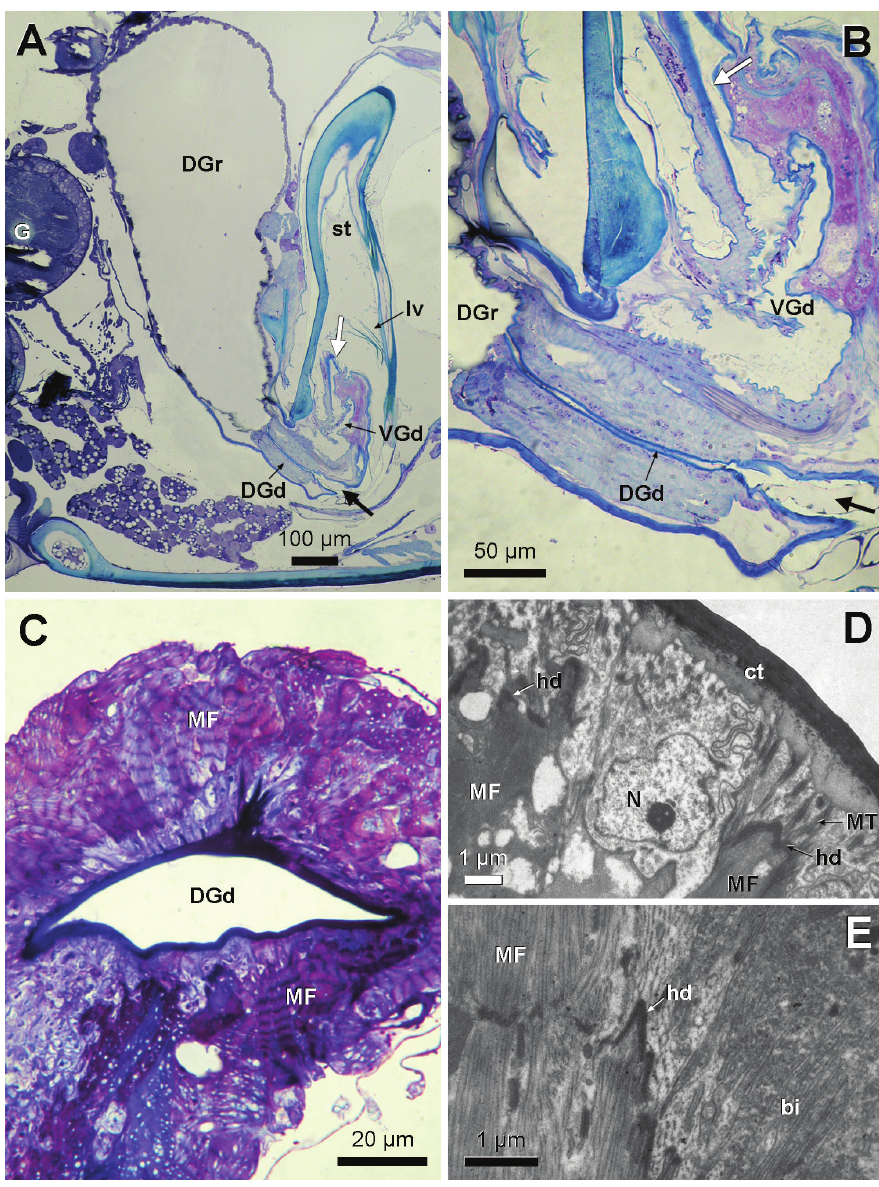
Figure 5. A Longitudinal semithin section through sting base region in Myzinum sp.2, showing Dufour gland opening ventrally of the sting base (black arrow), whereas the venom gland duct opens through the sting (white arrow) B Enlargement from A showing sting base region C Cross semithin section through Dufour gland duct in Myzinum sp.1, showing slit-like duct with attachment of dorsal and ventral muscle fibres (MF) D and E Electron micrographs of muscular attachments onto Dufour gland duct of Myzi- num sp.1. Myofilaments of muscle fibres (MF) transmit their pulling force onto bundles of microtubules (MT) in the duct cells via hemidesmosomes (hd). bi: basal invaginations, DGd: Dufour gland duct, DGr: Dufour gland reservoir sac. G: ganglion, lv: lancet valves, N: nucleus, st: sting, VGd: venom gland